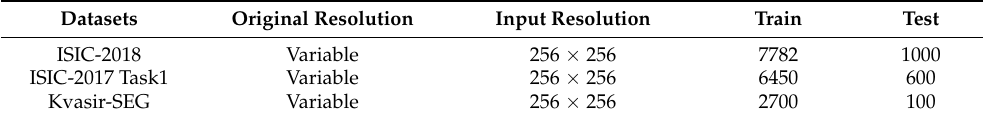
Table 2. Details of the medical segmentation datasets used in our